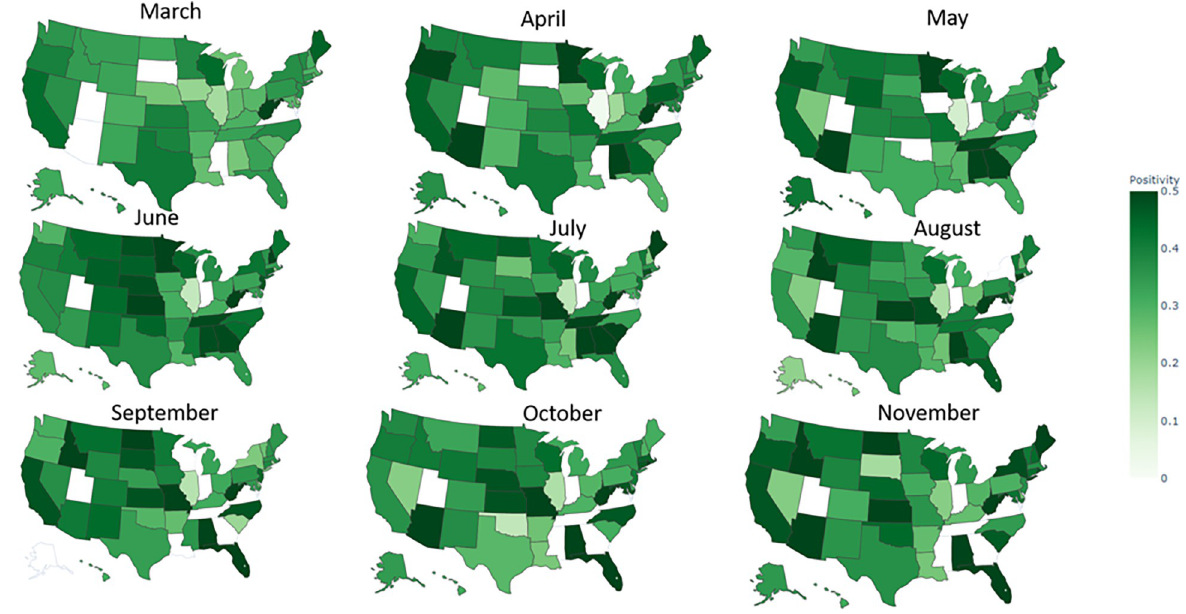
Fig 4. State–level evolution of tone (sentiment) during the study period: Evolution of positivity.